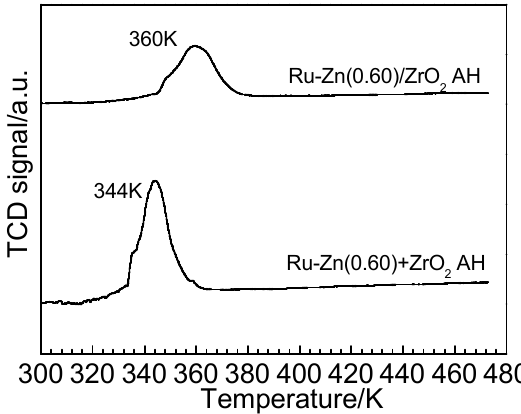
Figure 11. H 2 -temperature-programmed reduction profiles of Ru-Zn(0.60)/m-ZrO 2 and unsupported Ru-Zn (0.60) after catalytic experiments.